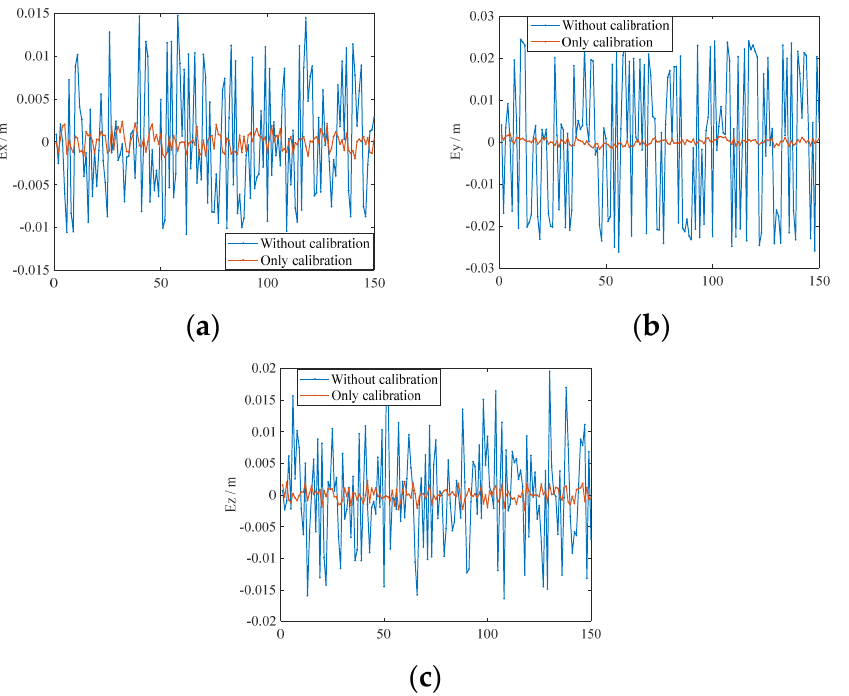
Figure 12. Comparison of kinematic calibration and non-calibration in the X- ( a ) Y- ( b ) and Z- ( c ) directions.